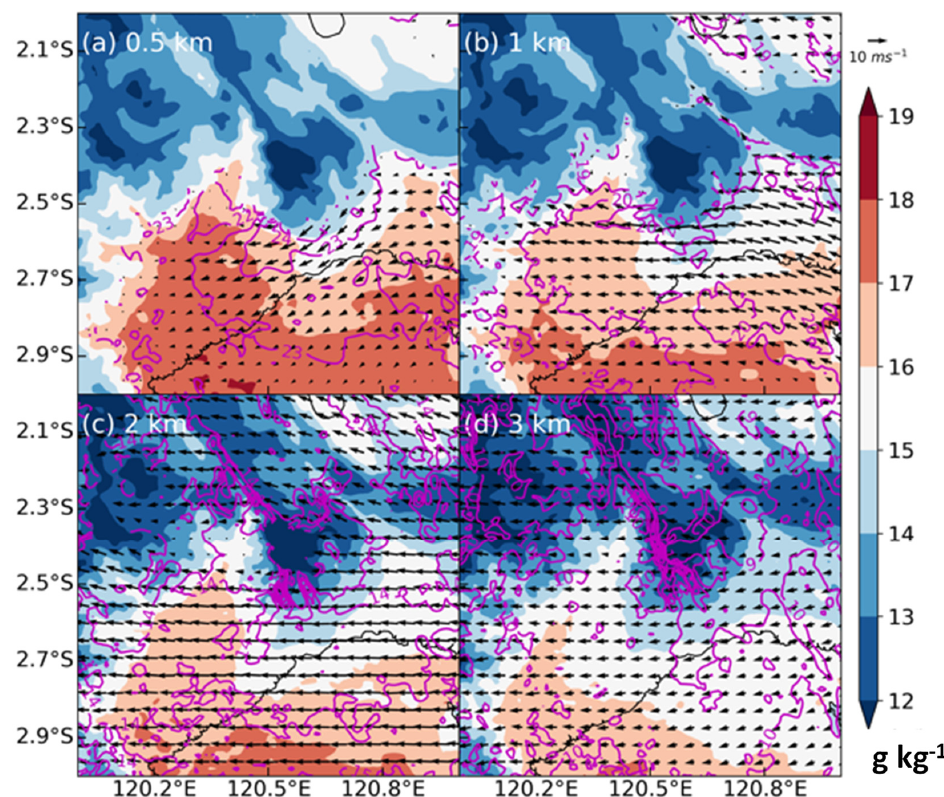
Figure 10. Horizontal distribution of temperature (contours) and water vapor mixing ratio (shading) simulated by the WRF model at 1 km resolution and averaged over 13 July 2020 (19:00–00:00 LST) at an altitude of ( a ) 0.5 km, ( b ) 1 km, ( c ) 2 km, and ( d ) 3 km.